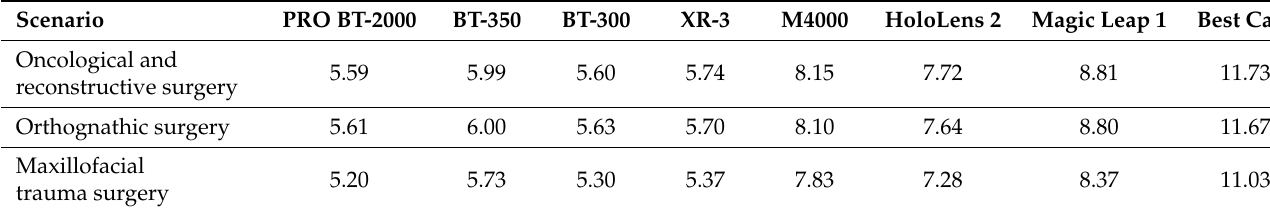
Table 7. Devices’ overall scores for maxillofacial